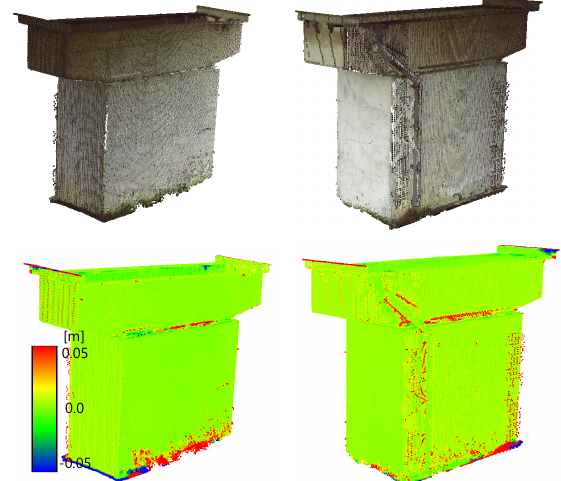
Figure 9. Top row shows the point clouds of the bridge column captured by a terrestrial laser scanner and bottom row depicts the error distributions of the final dense mesh model on the laser-scanned point